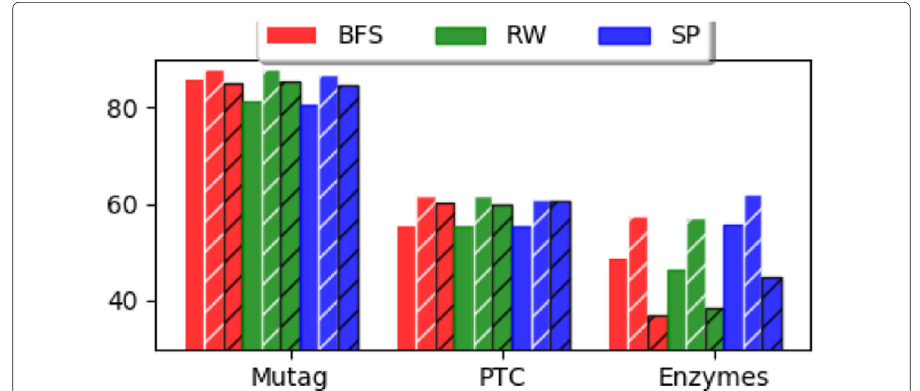
Fig. 11 Type of substructure (solid: WL0, white hatch: WL1, black